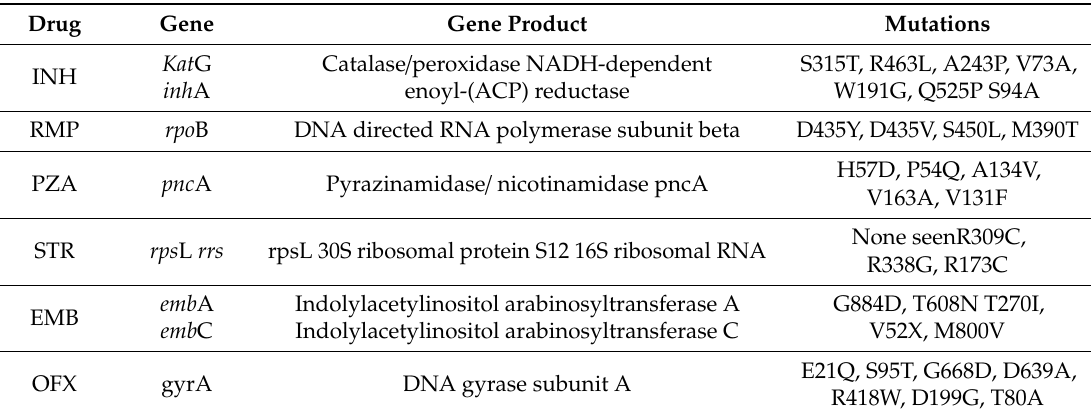
Table 6. Drugs, genes, and drug-resistance associated